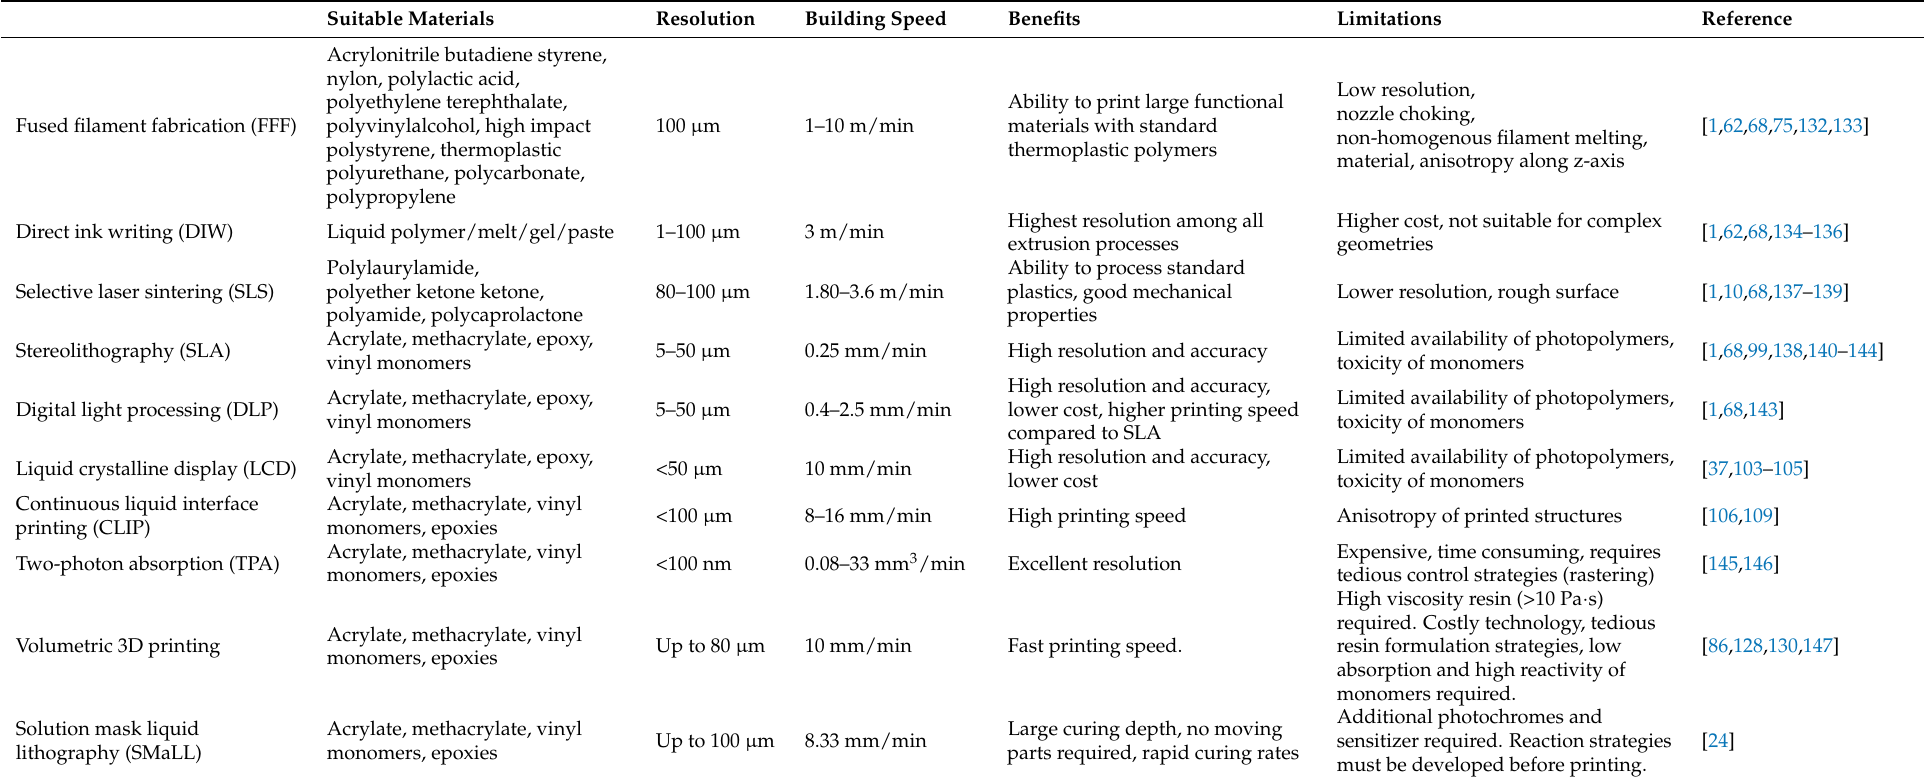
Table 3. Characteristics of selected common 3D printing